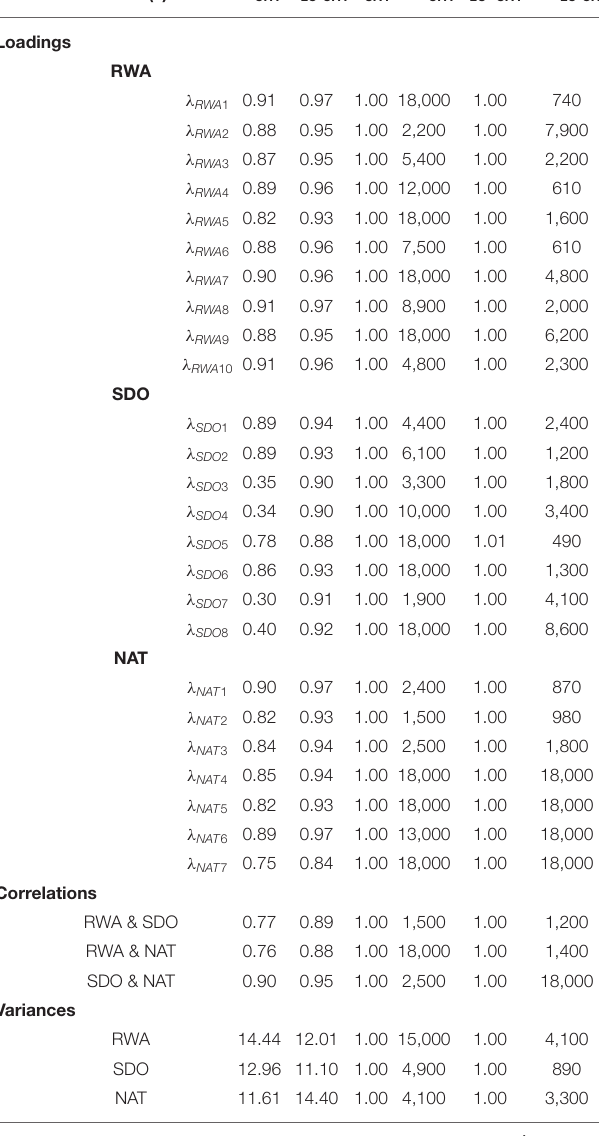
TABLE 5 | Loading table of LC-CFA and traditional